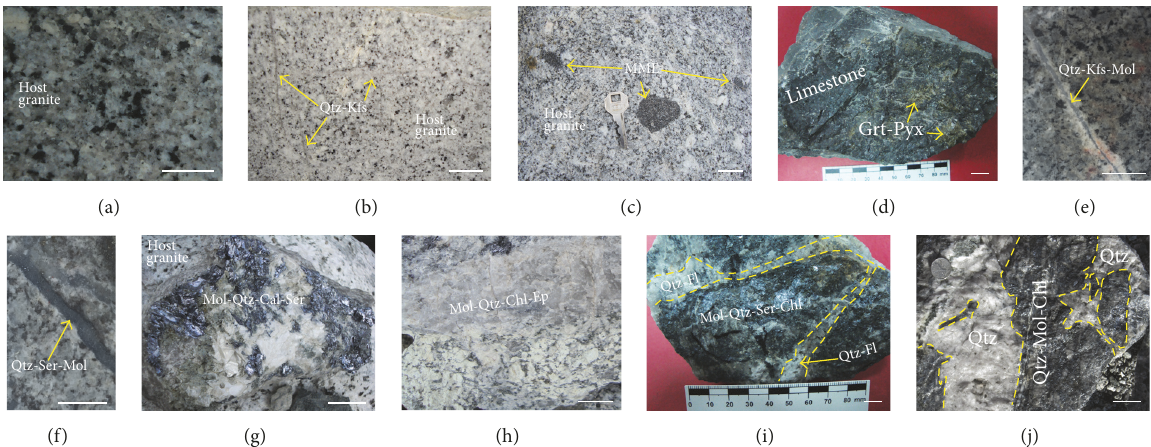
Figure 2: Hand-specimen photographs from the Haisugou Mo deposit showing the granite and the alteration and vein types from different hydrothermalstages.(a)Polishedgranitesampleshowingthemajormineralsincludingplagioclase,quartz,K-feldspar,biotite,andamphibole. (b) Barren quartz-K-feldspar veinlets in granite recording the earliest hydrothermal alteration in Haisugou. (c) Mafic microgranular enclaves in granite. (d) Garnet-pyroxene skarn in limestone in the contact zone between the country rocks and the granite. (e) Slightly mineralized P-stage quartz vein with K-feldspar halos. (f) S-stage quartz-sericite-molybdenite vein. (g) S-stage molybdenite-quartz-calcite-sericite vein. (h) S-stage quartz-molybdenite vein with chlorite and epidote halos. (i) Hydrothermal breccias containing clasts of S-stage molybdenite- quartz-sericite-chlorite aggregates cemented by B-stage barren quartz and fluorite. (j) Hydrothermal breccias containing clasts of S-stage molybdenite-quartz-chloriteaggregatescementedbyB-stagebarrenquartz.Thescalebaris1 cmineachphotograph.Cal:calcite;Chl:chlorite; Ep: epidote; Fl: fluorite; Grt: garnet; Kfs: K-feldspar; MME: mafic microgranular enclave; Mol: molybdenite; Pyx: pyroxene; Qtz: quartz; Ser: sericite.